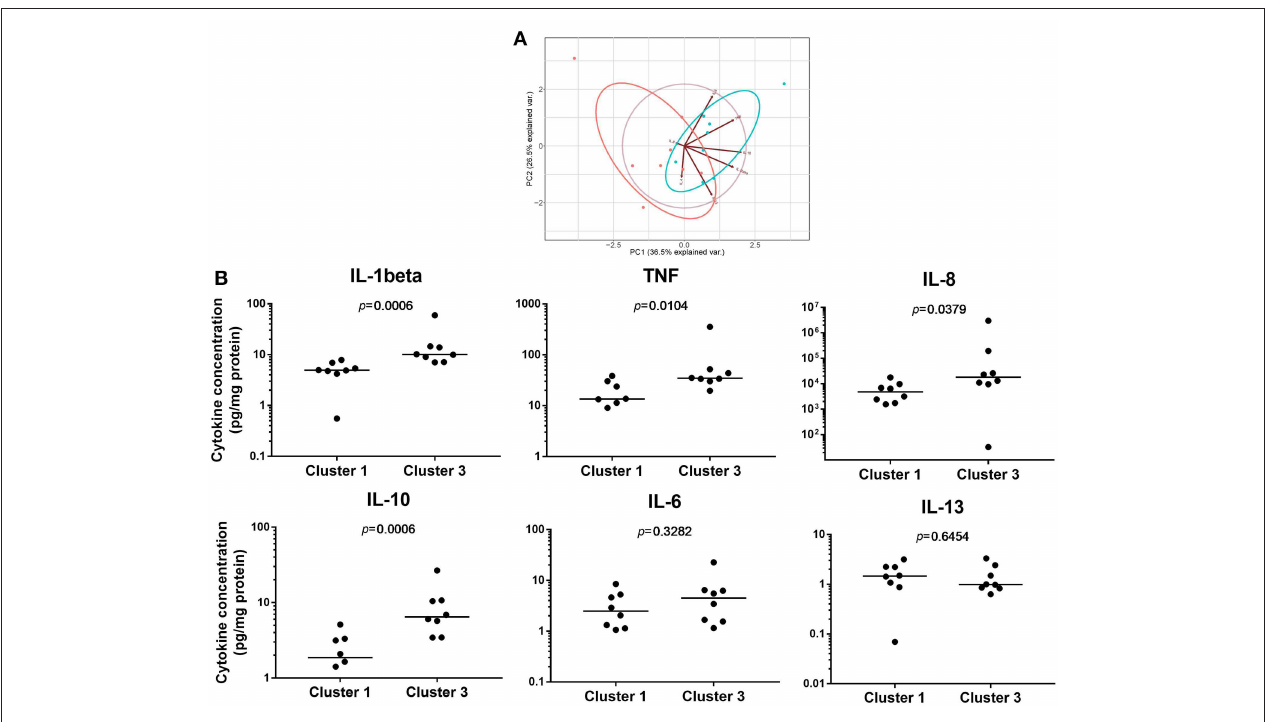
FIGURE 2 | Pro-inflammatory cytokine levels can reflect differences between NF- κ B-regulated luciferase activity defined clusters. (A) Principal component analysis (PCA) based on concentrations of pro-inflammatory cytokines secreted to the medium of 200ng/mL lipopolysaccharide (LPS)-stimulated patient PBMDMs from Cluster 1 (red), and Cluster 3 (blue) samples. (B) Quantification of individual cytokines levels (pg/mL) released from patient PBMDMs over 20h stimulation with LPS. Statistical comparisons between clusters were made using the Mann-Whitney U -test. Individual p -values are reported on each chart, with differences considered significant when p <